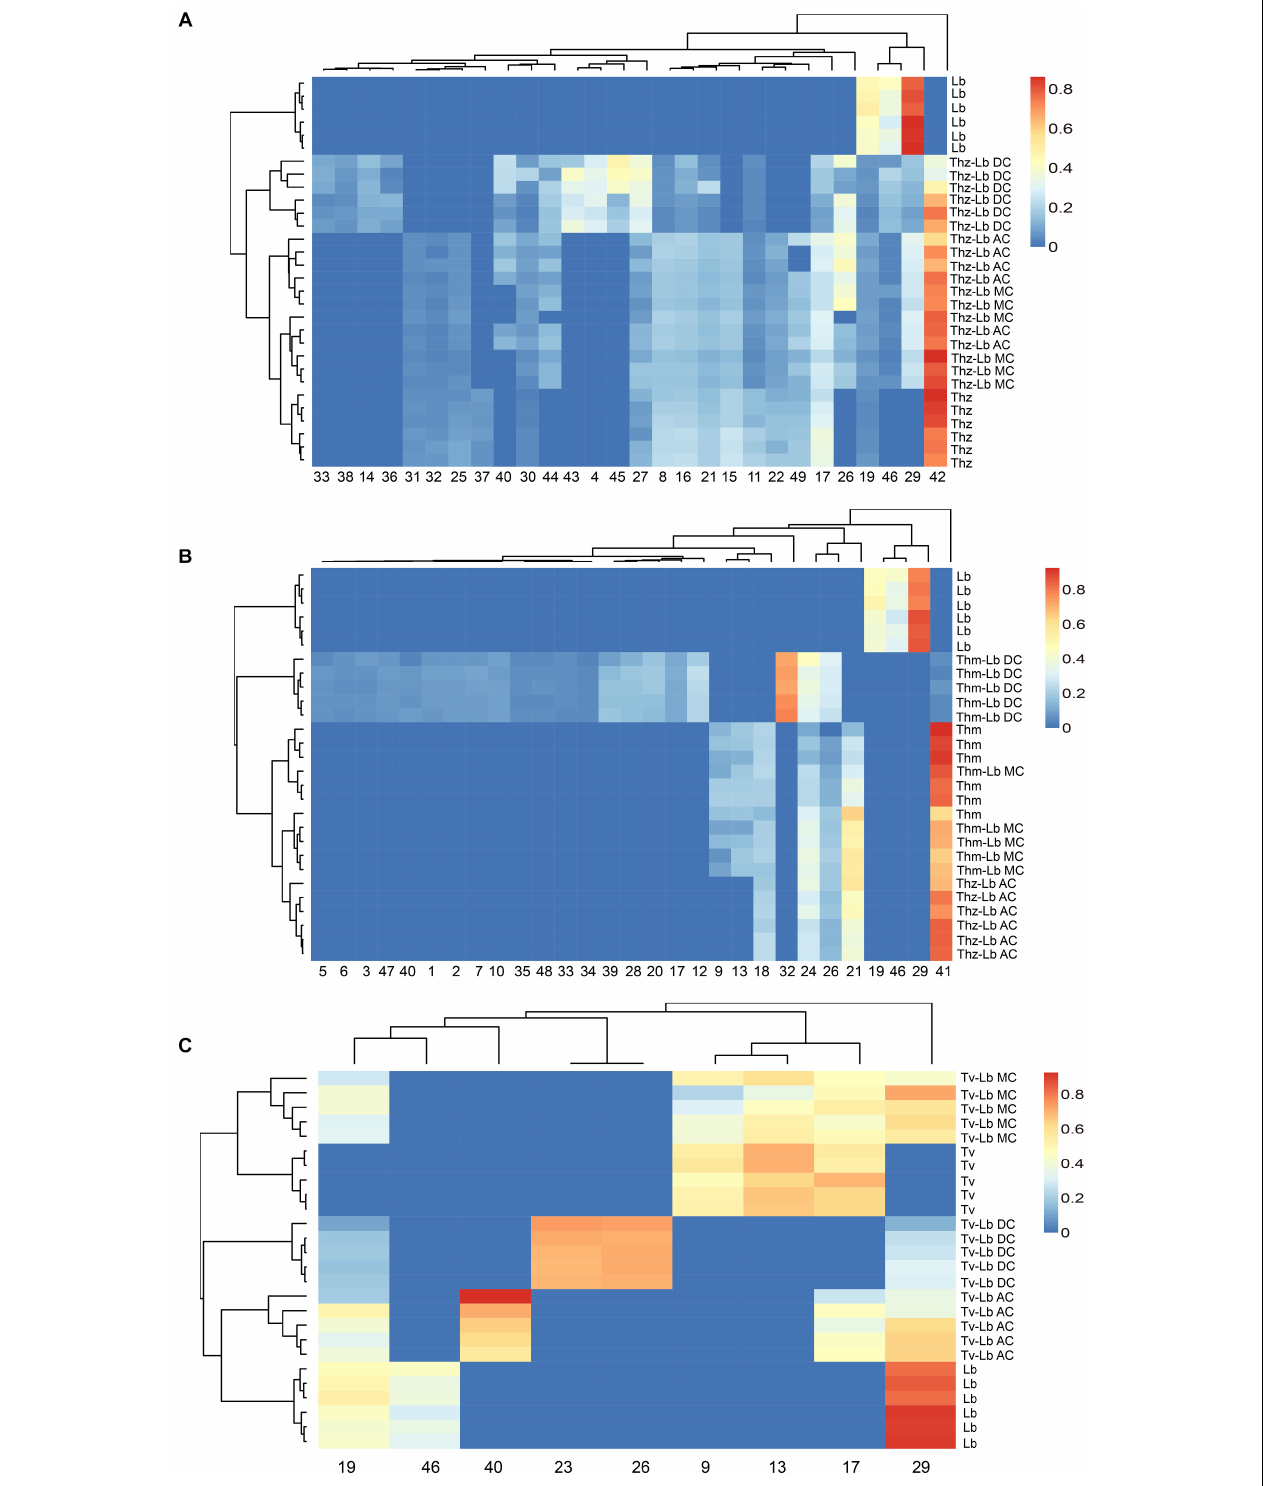
FIGURE 6 | Heat map clustering of VOC profiles from T. harzianum (Thz), T. hamatum (Thm), T. velutinum (Tv), L. bicolor (Lb), and Trichoderma - Lb co-cultures. (A) VOC profiles of Thz, Lb and their co-cultures; (B) VOC profiles of Thm, Lb and their co-cultures; (C) VOC profiles of Tv, Lb and their co-cultures. Data were Hellinger-transformed prior to clustering. NC, no contact; AC, airborne contact; MC, media contact; DC, direct contact. Compound numbers refer to Supplementary Table S2 .